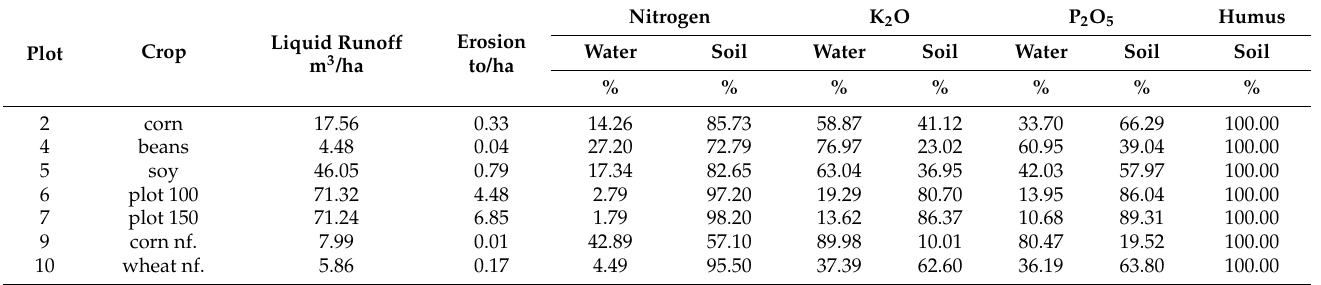
Table 9. Percentage repartition of the losses of macroelements through water and soil, SCDCES—MM Perieni.